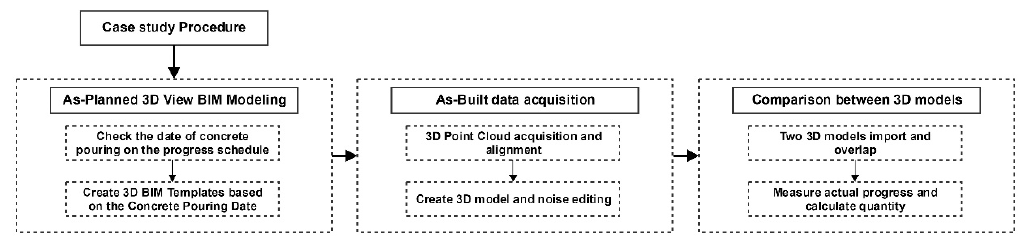
Figure 4. Procedure for the case study.